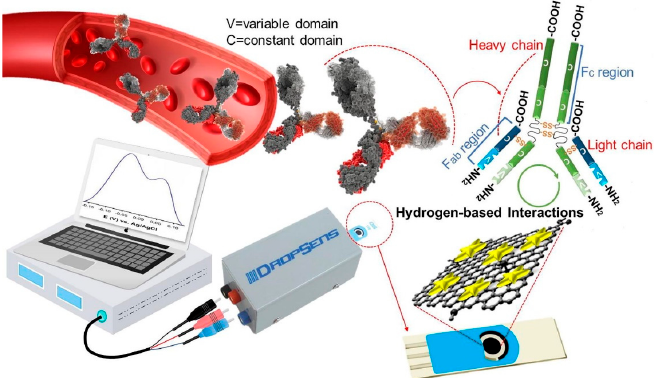
Figure 7. Electrochemical detection of IgG antibody through GO/Au nanostar composites. Repro- duced with permission from Ref. [3]. Copyright 2021 Elsevier. In an interesting work from Wei Gao research group, they developed a wireless gra- phene-based multiplexed telemedicine platform for electrochemical detection of COVID-